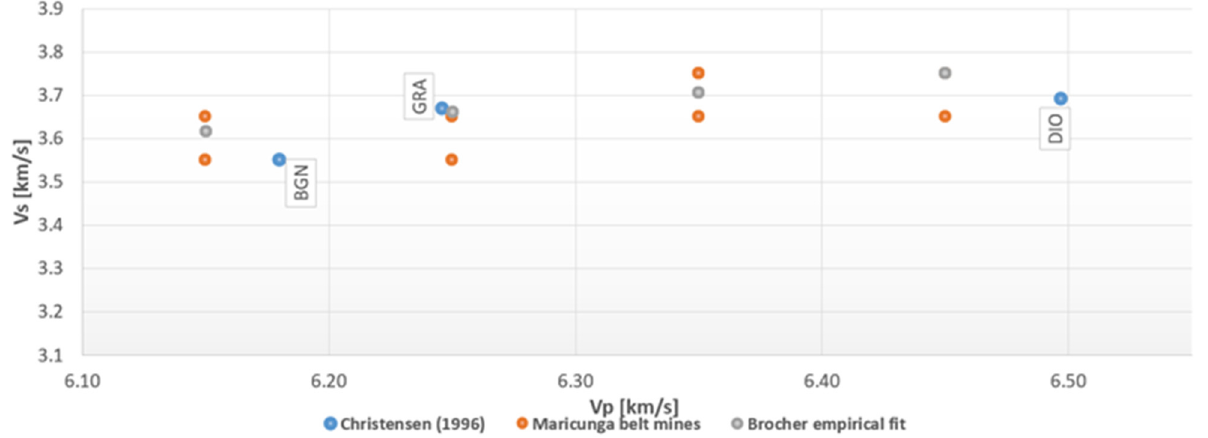
Figure 7. Vs is plotted as a function of Vp for biotite (tonalite), gneiss (BGN), diorite (DIO), and granite-granodiorite (GRA) lithologies. Blue dots represent the average Vp and Vs values obtained experimentally by Christensen [28] under a pressure of 200 MPa. Orange dots represent the Vp and Vs values observed in the MB gold deposits obtained from the final velocity models at a 6.5 km depth. The grey dots represent the ratio between the observed Vp and the Vs fitted according to the formula from Brocher (Equation (1)). Table 1. Information regarding the main lithologies and seismic velocities of the main gold deposits in the MB, including deposit type, age, Vp, Vs, and Vp/Vs values obtained from the original velocity model at 6.5 km depth, Vs velocities derived from the formula from Brocher [29] calculated from Equation (1), and the lithology associated with the interpretation of these velocity values.